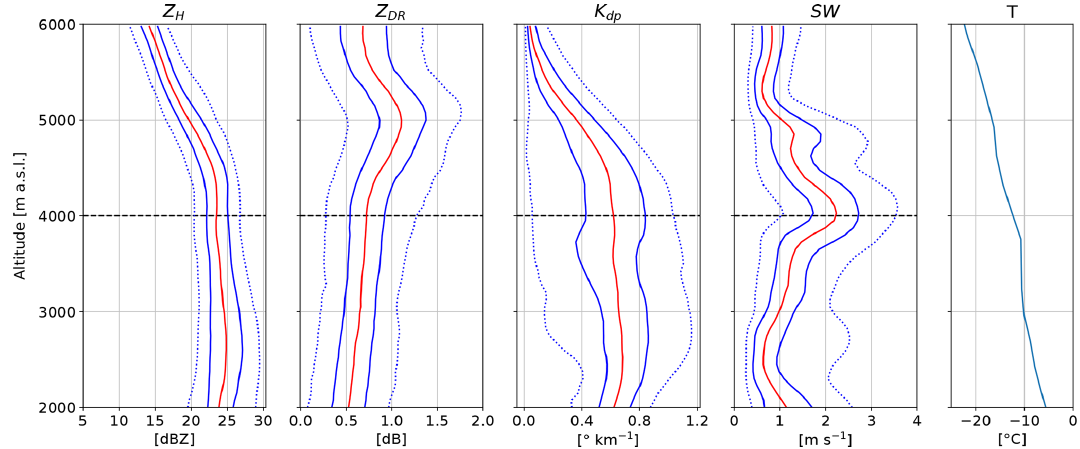
Figure 10. Same as Fig. 7 for 06:00 to 08:00UTC on 28 February 2018. The statistics are based on 21 RHIs towards the MHS site. The dashed black line shows the lower limit of the WCB (black contour in Fig. 5a, b, c).